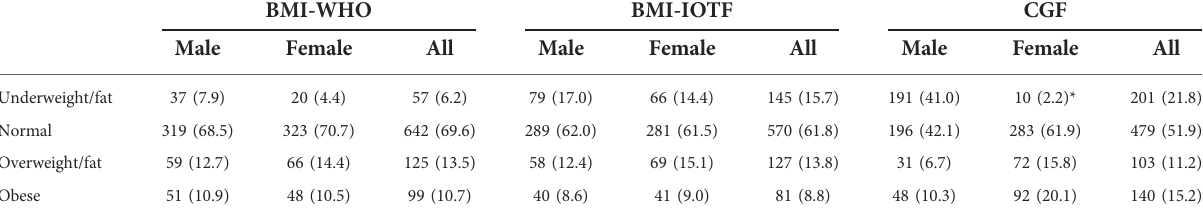
TABLE 2 Prevalence of nutritional status [N (%)] based on the three international references ( n